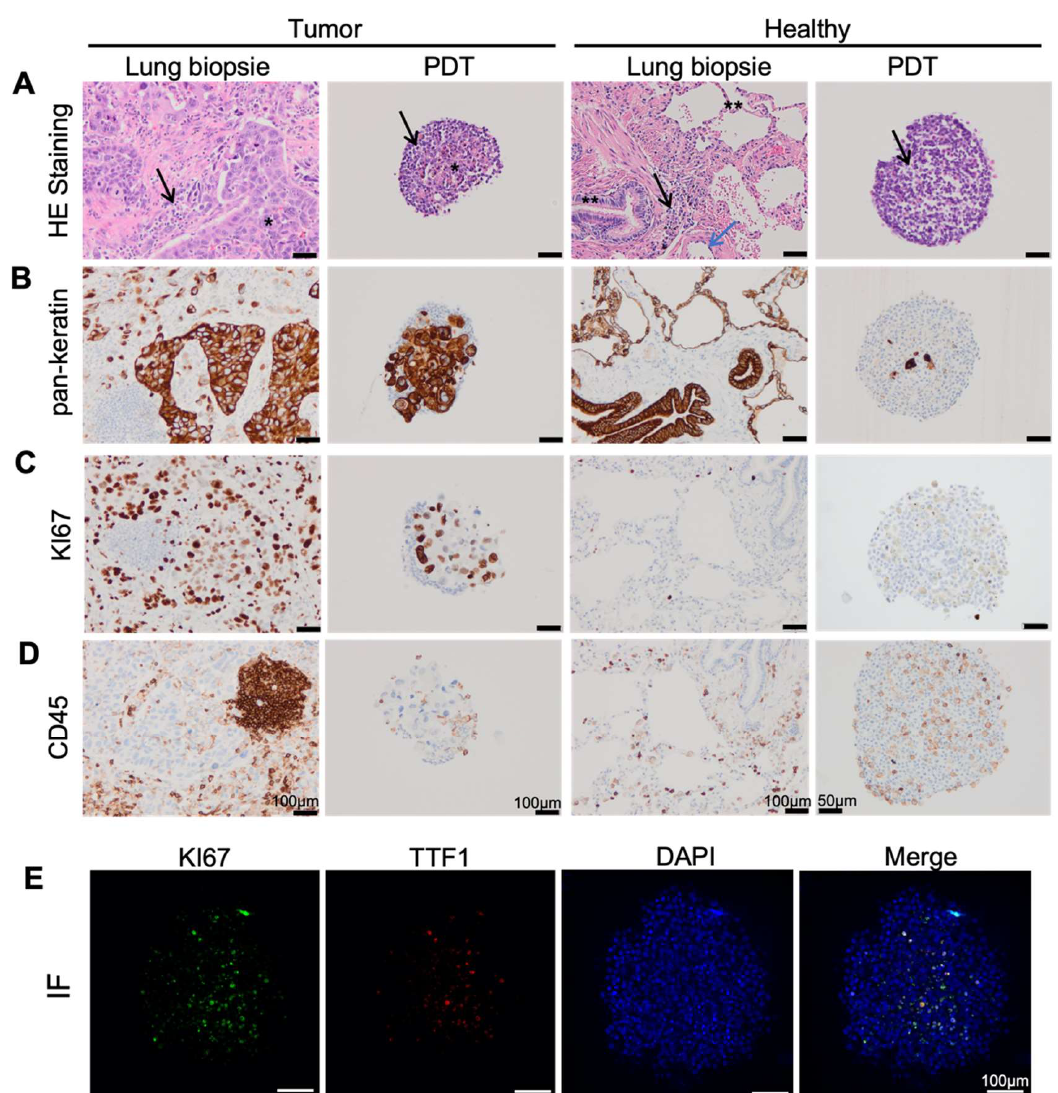
Figure 2. Characterization of patient-derived tumoroids (PDTs). ( A – D ) Immunohistochemistry analyses performed on the lung biopsy and its corresponding PDTs with indicated specific antibodies. *: epithelial tumoral cells, **: epithelial non tumoral cells (normal respiratory and alveolar epithelium), black arrow: inflammatory cells, blue arrow: endothelial contingent. ( E ) Immunofluorescence analyses performed on PDTs with indicated stainings.